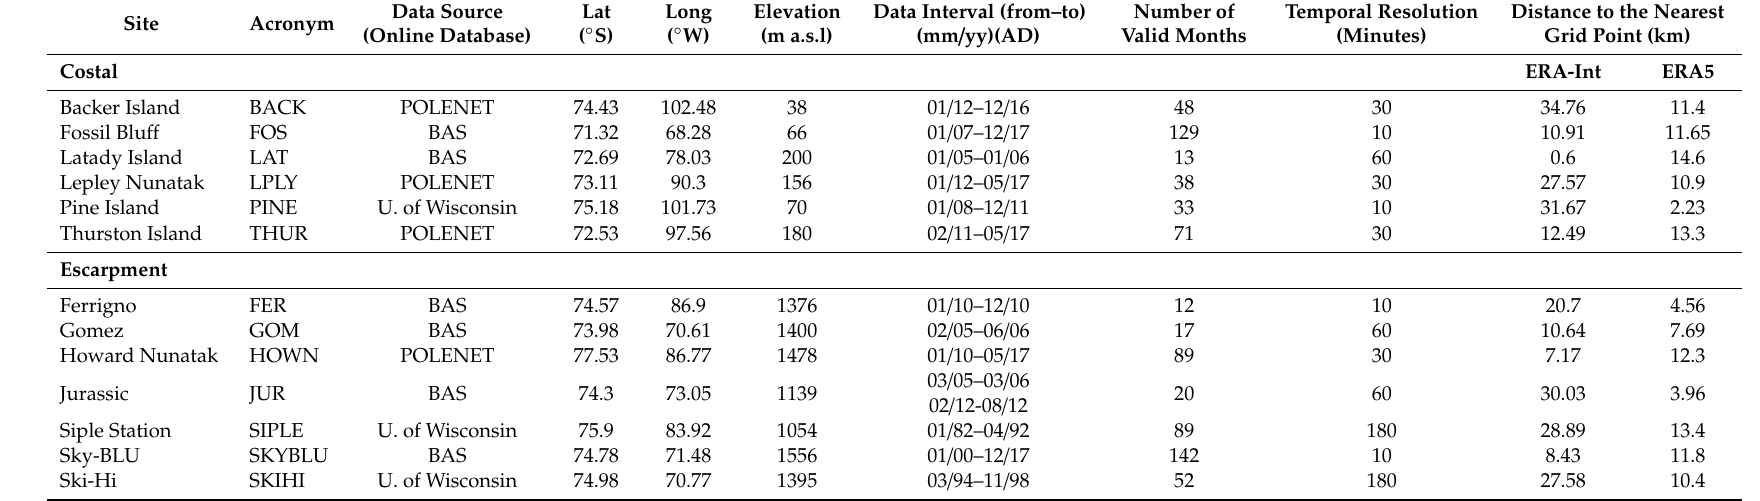
Table 1. Summary of the AWS geographical location and main features of the AWS datasets. POLENET: Polar Earth Observing Network. BAS: British Antarctic